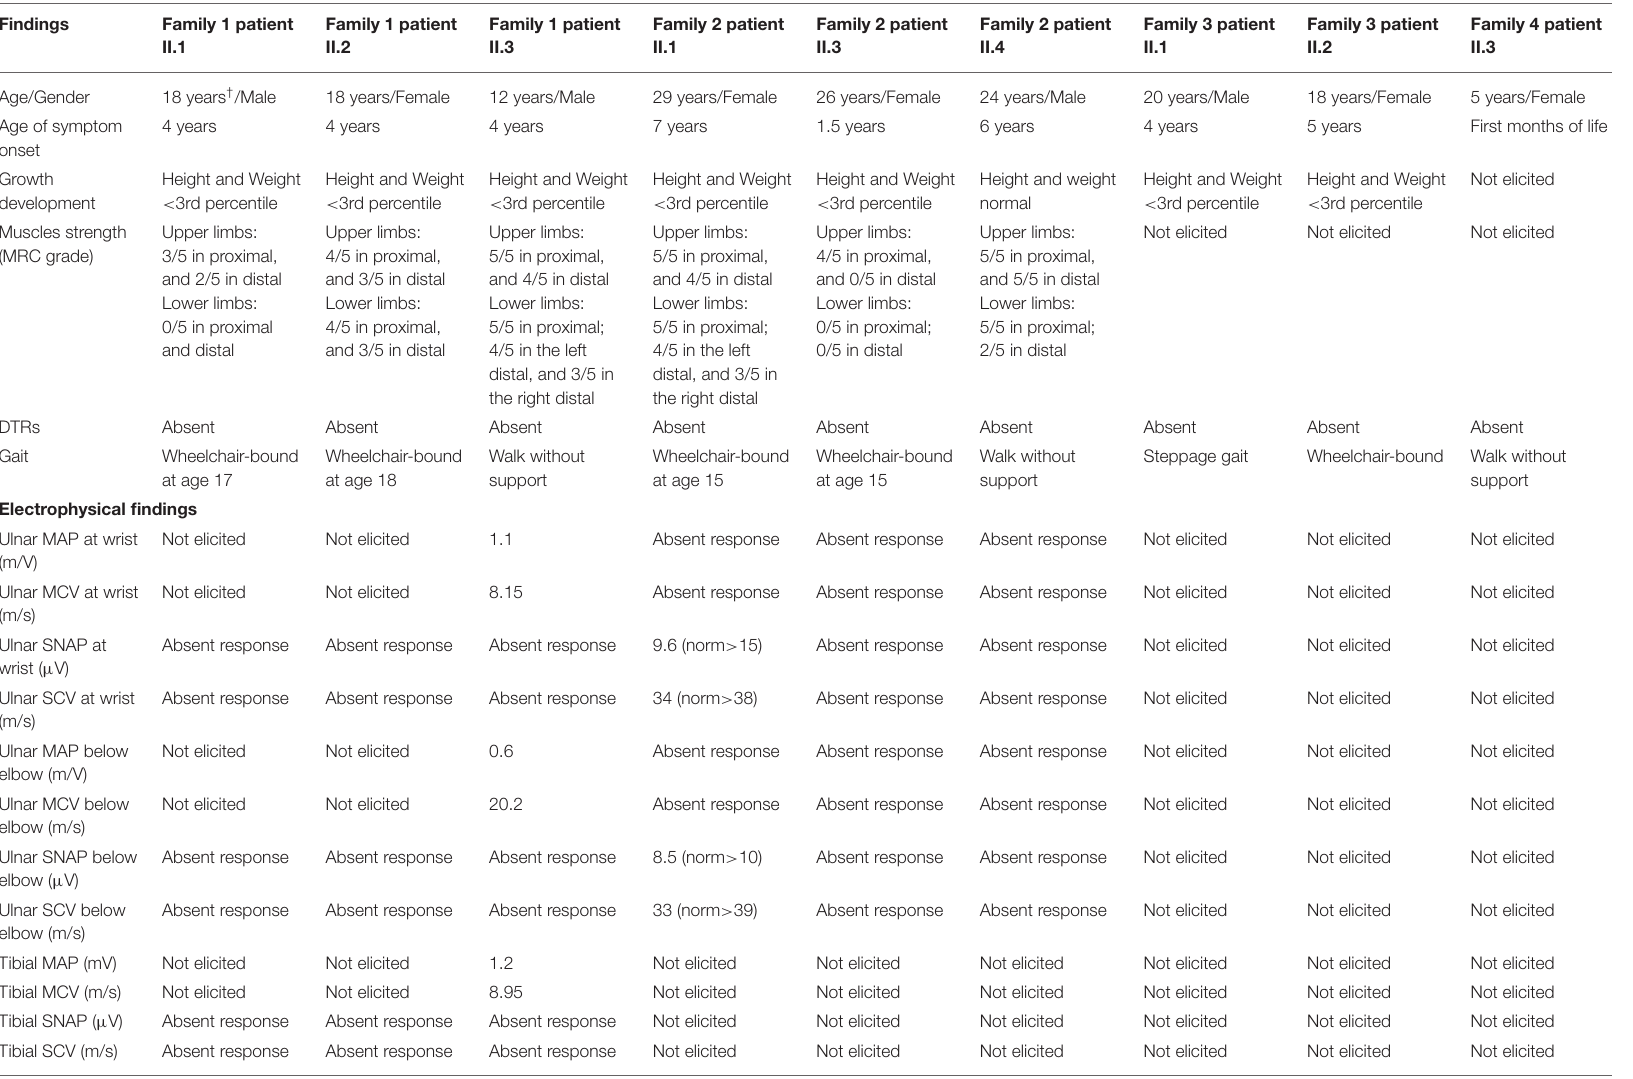
TABLE 1 | Clinical, electrophysiological, and molecular genetic characteristics of the sibling patients from family 1, 2, 3, and 4.